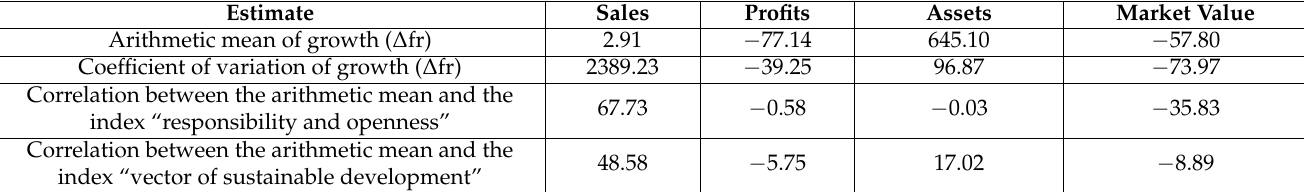
Table 3. Evaluation of the impact of CSR on the financial risks of Russian companies in